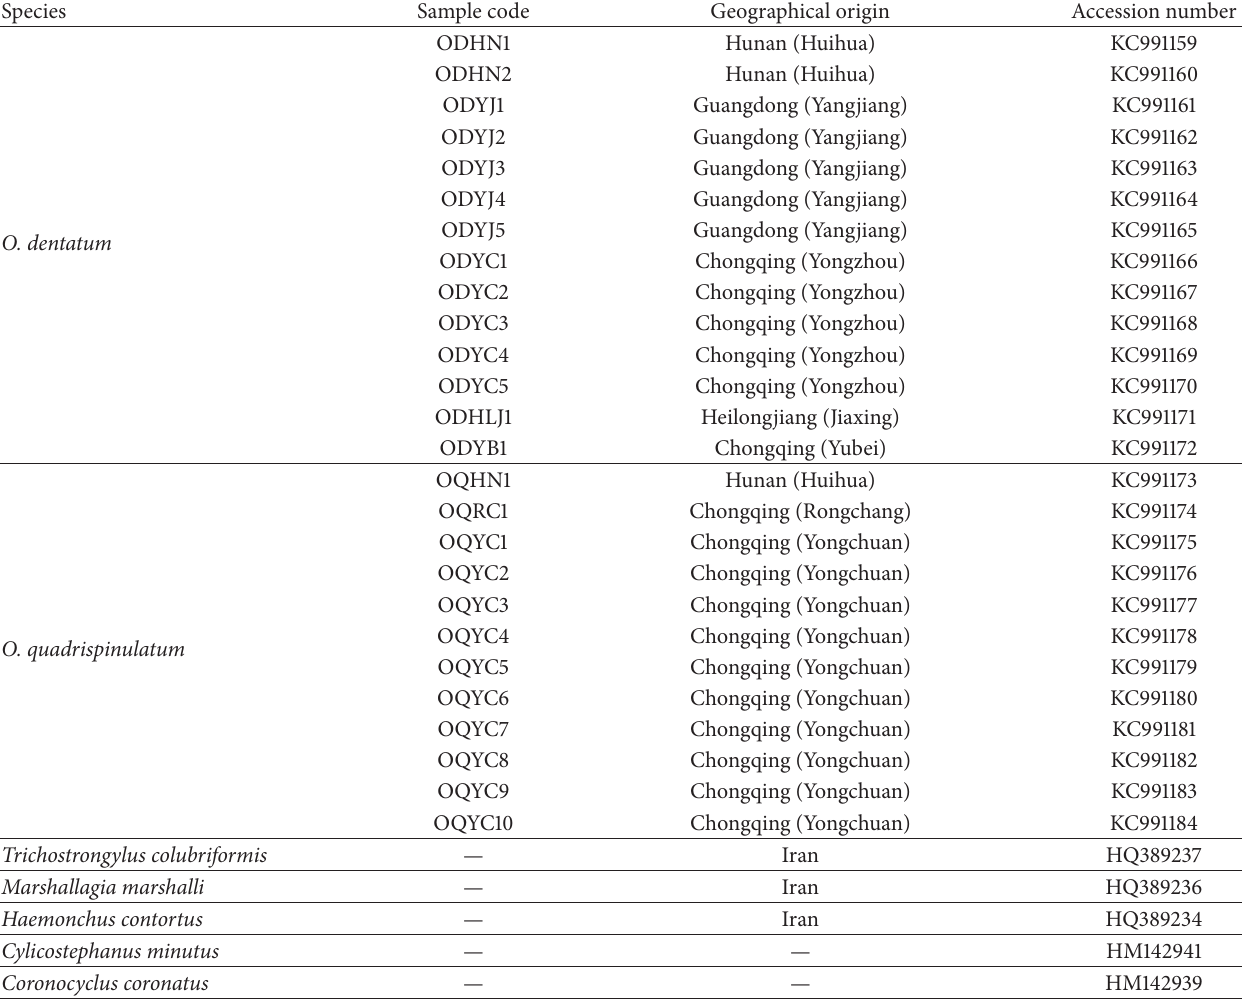
Table 1: Geographical origins, sample codes, and GenBank accession numbers of Oesophagostomum dentatum and O. quadrispinulatum samples used in the present